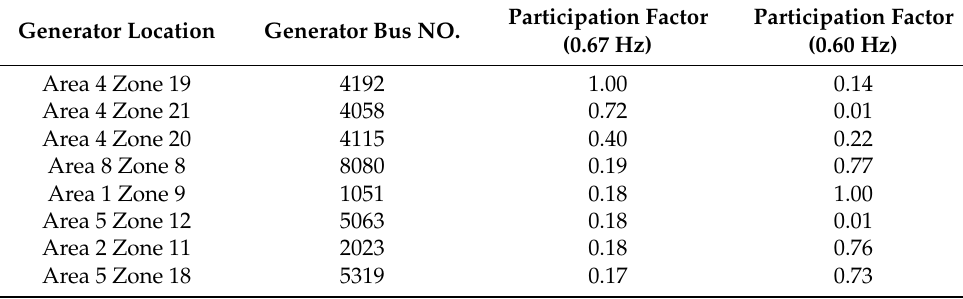
Table 2. Participation factor for natural 0.67 Hz and 0.60 Hz oscillation.